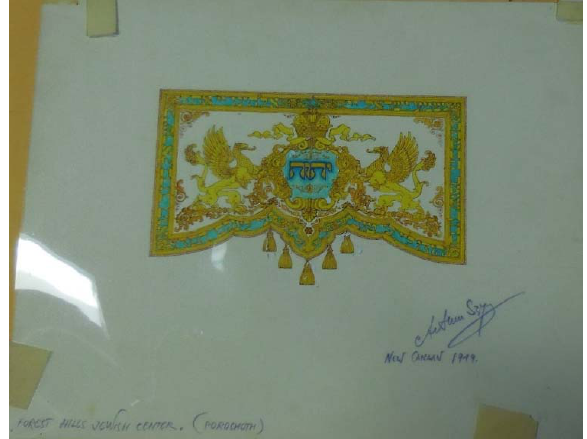
Figure 7. Arthur Szyk, ink sketch for the “Parochuth [sic]”, 1949.